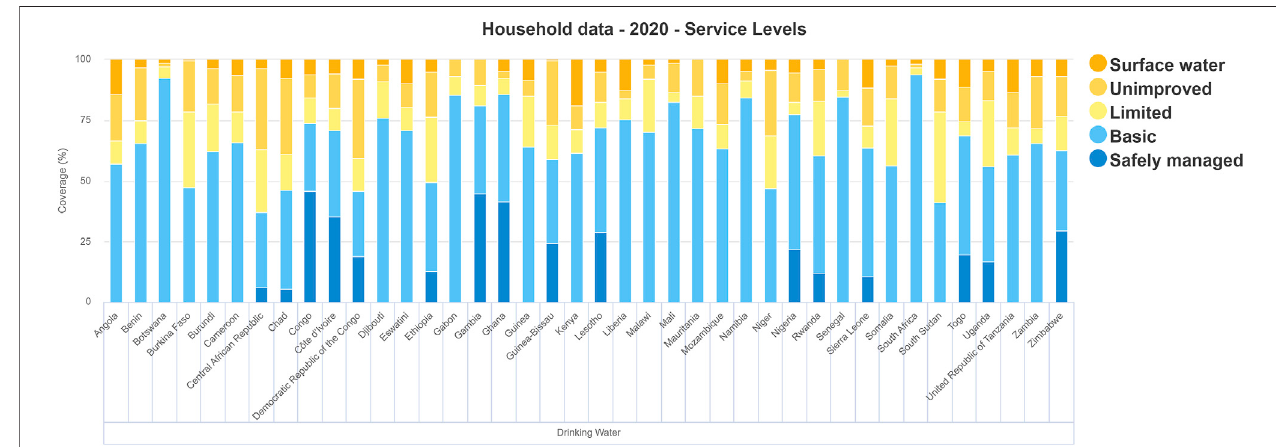
FIGURE 2 | Household data - 2020- Service